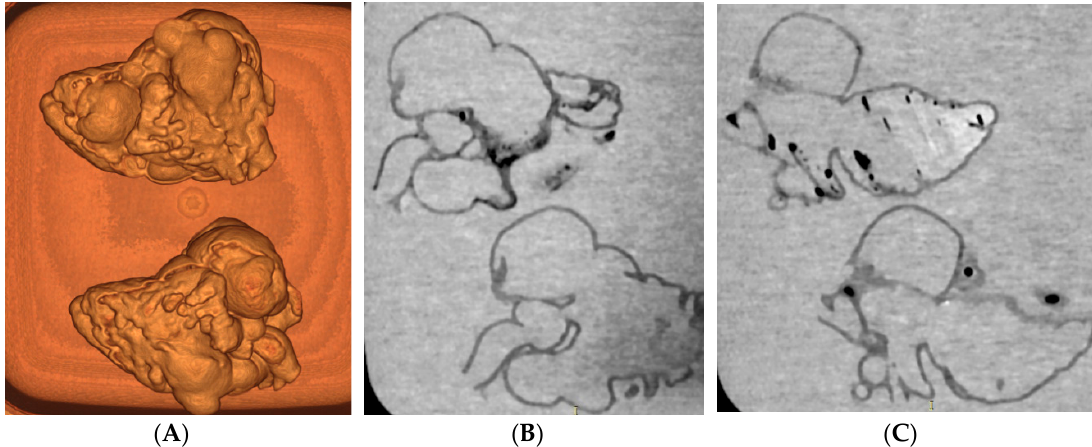
Figure 8. CT scan of 3D printed heart models created using different printing materials. ( A ) 3D volume rendering showing the 3D printed models without contrast medium (top: Tango Plus material, bottom: TPU material). ( B , C ) Coronal multiplanar reformatted contrast-enhanced CT images showing 3D printed models with Tango Plus (left) and TPU (right) materials. Air bubbles are noticed in the model with TPU material. TPU—thermoplastic polyurethane. Reprinted with permission under the open access from Lau et al. [45].